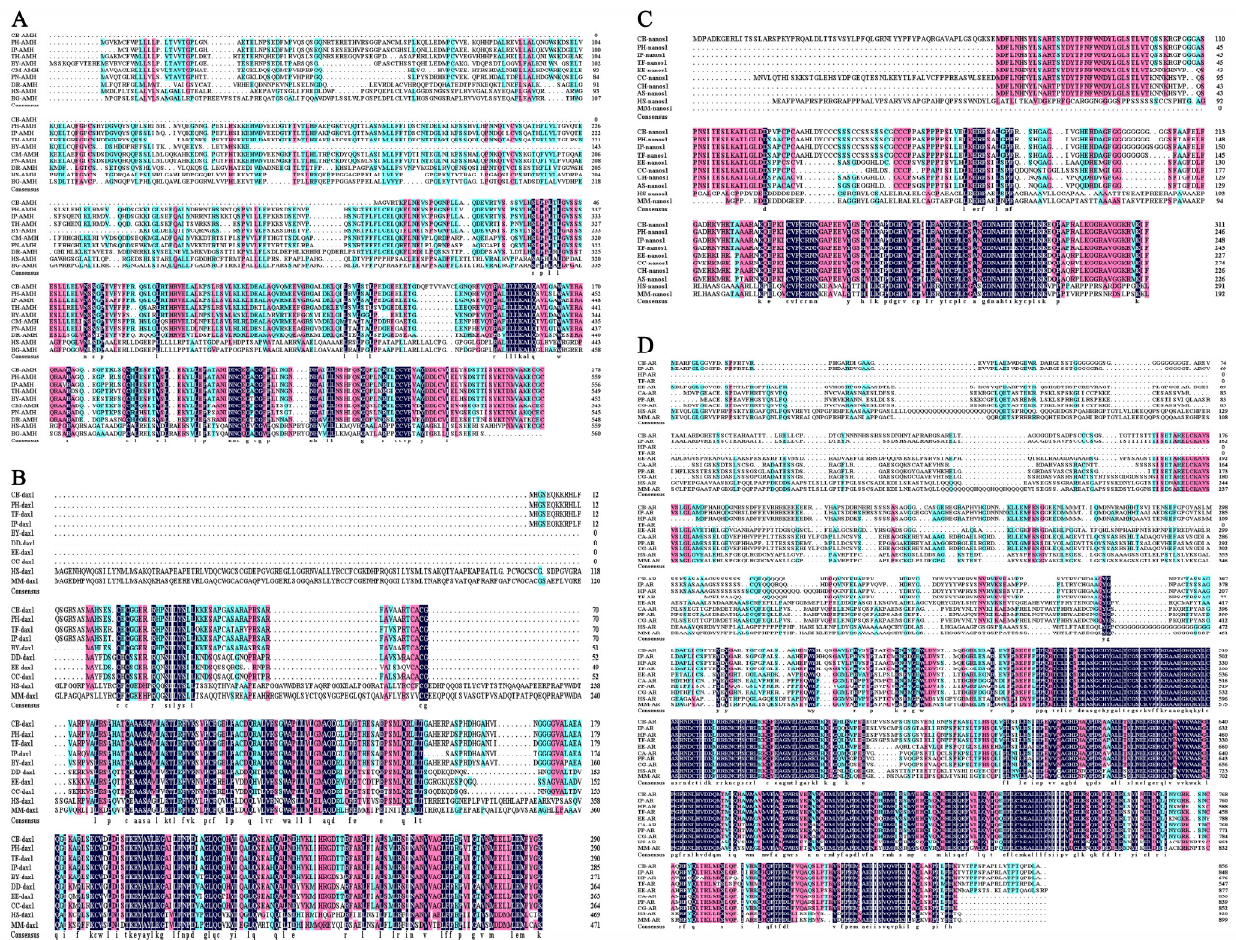
Figure 5. Comparison of the amino acid sequences of AMH, DAX1, NANOS1 and AR of C. bouderius with other species. CB: C. bouderius . PH: Phypophthalmus . IP: Ictalurus punctatus . TF: Tachysurus fulvidraco . BY: Bagarius yarrelli . CM: Colossoma macropomum . PN: Pygocentrus nattereri . DR: Danio rerio . HS: Homo sapiens . BG: Bos grunniens . Regions with the same color represent conserved sites of the sequence, and Black represents fully conserved loci. ( A ) Comparison of amino acid sequences of AMH in different species. ( B ) Comparison of amino acid sequences of DAX1 in different species. ( C ) Comparison of amino acid sequences of NANOS1 in different species. ( D ) Comparison of amino acid sequences of AR in different